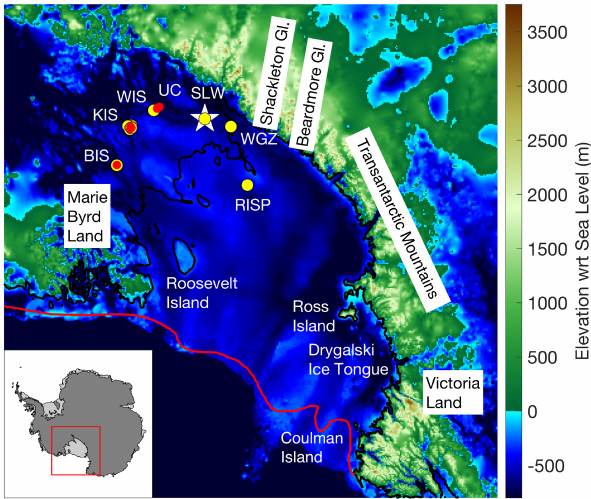
Figure 1. Location of sites and place names used in this study. Sites where measurements were taken and examined in this study are as follows: RISP (Ross Ice Shelf Project), WGZ (Whillans Ground- ing Zone), SLW (Whillans Subglacial Lake), UC (Unicorn), WIS (Whillans Ice Stream), KIS (Kamb Ice Stream), and BIS (Bind- schadler Ice Stream). Background image uses bed elevation data (Fretwell et al., 2013). Yellow dots denote the location of sediment cores taken for radiocarbon and organic matter analyses. Red dots denote the location of deep ice temperature profiles examined in this study. The white star indicates the location where sediment porewa- ter was collected and analyzed. Table 1. Observed basal temperature gradients reported in Engel- hardt (2004) and used in the temperature diffusion